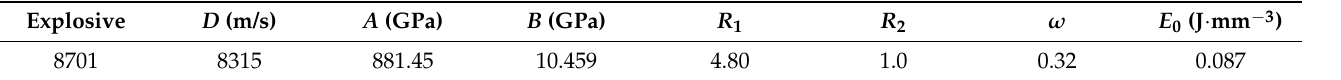
Table 3. JWL EOS parameters of explosive